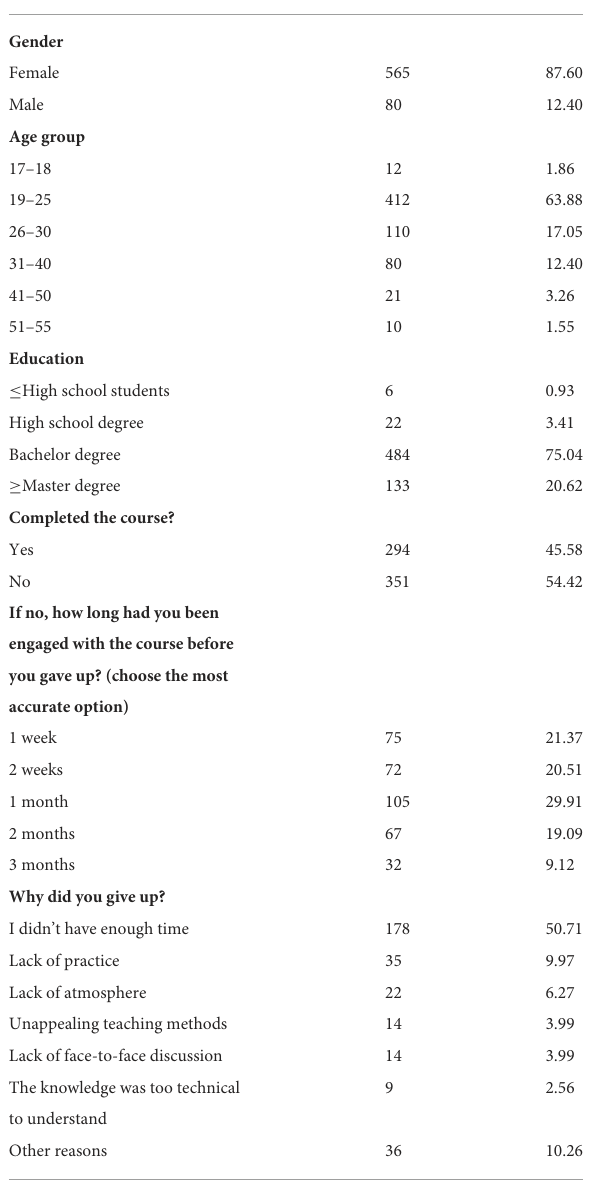
TABLE 2 Demographic information of respondents ( N =